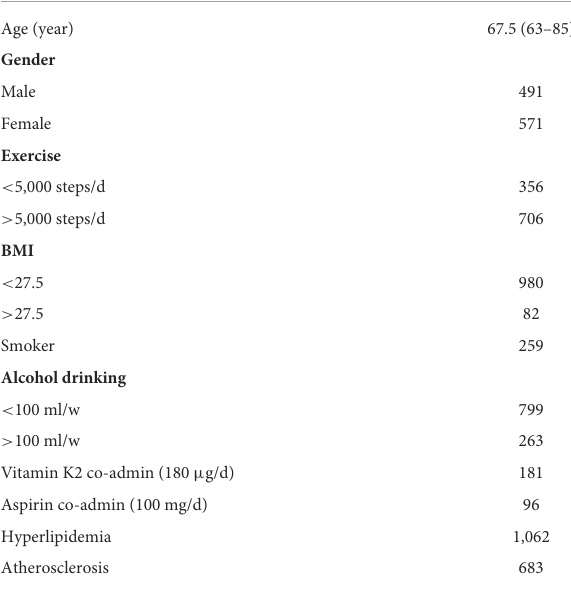
TABLE 1 Baseline characteristics of the